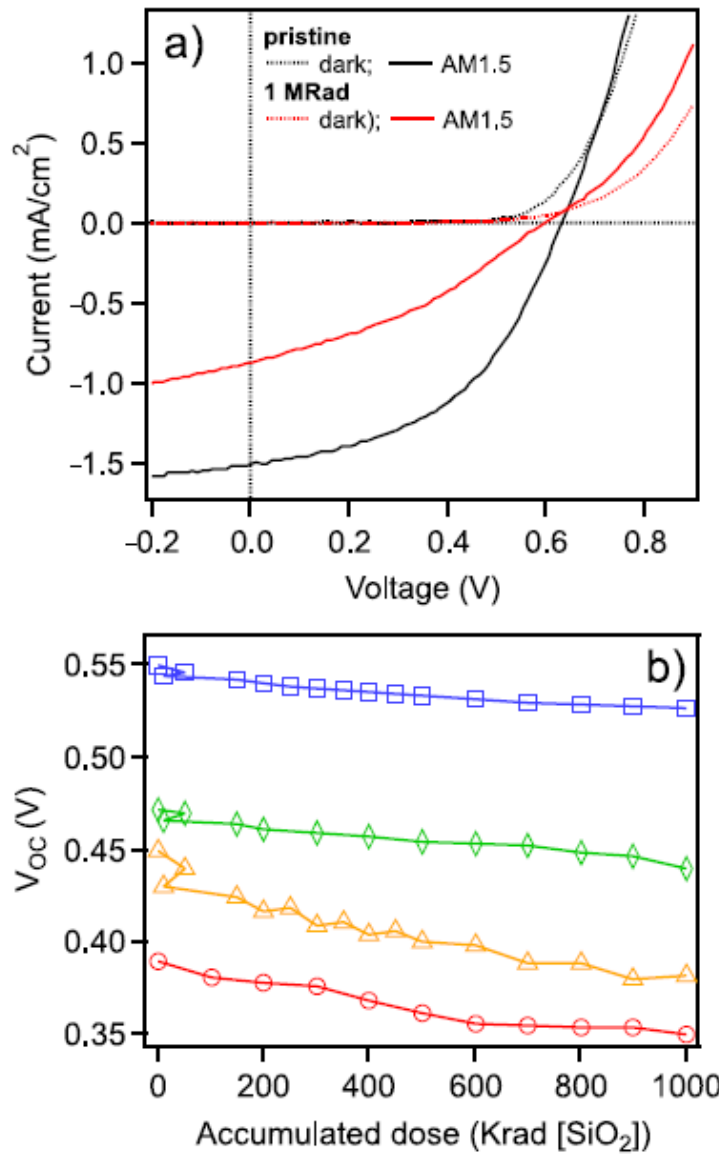
Figure 15. ( a ) J ‐ V curves of typical P3HT/PCBM devices before (black) and after (red) exposure to X ‐ rays; ( b ) responses of several devices with accumulated radiation dosage illustrating the effect of device ‐ to ‐ device variation. Copyright permission from [140].